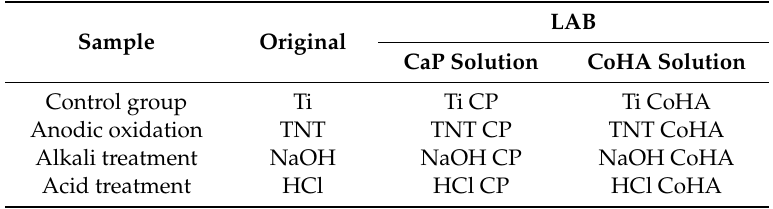
Table 1. Summary of samples for the synthesis systems.